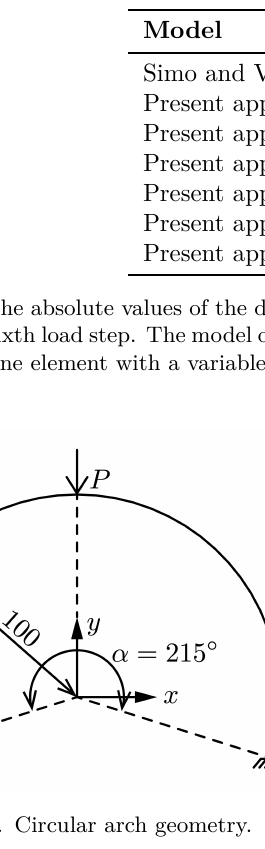
maximum number of 3 iterations per